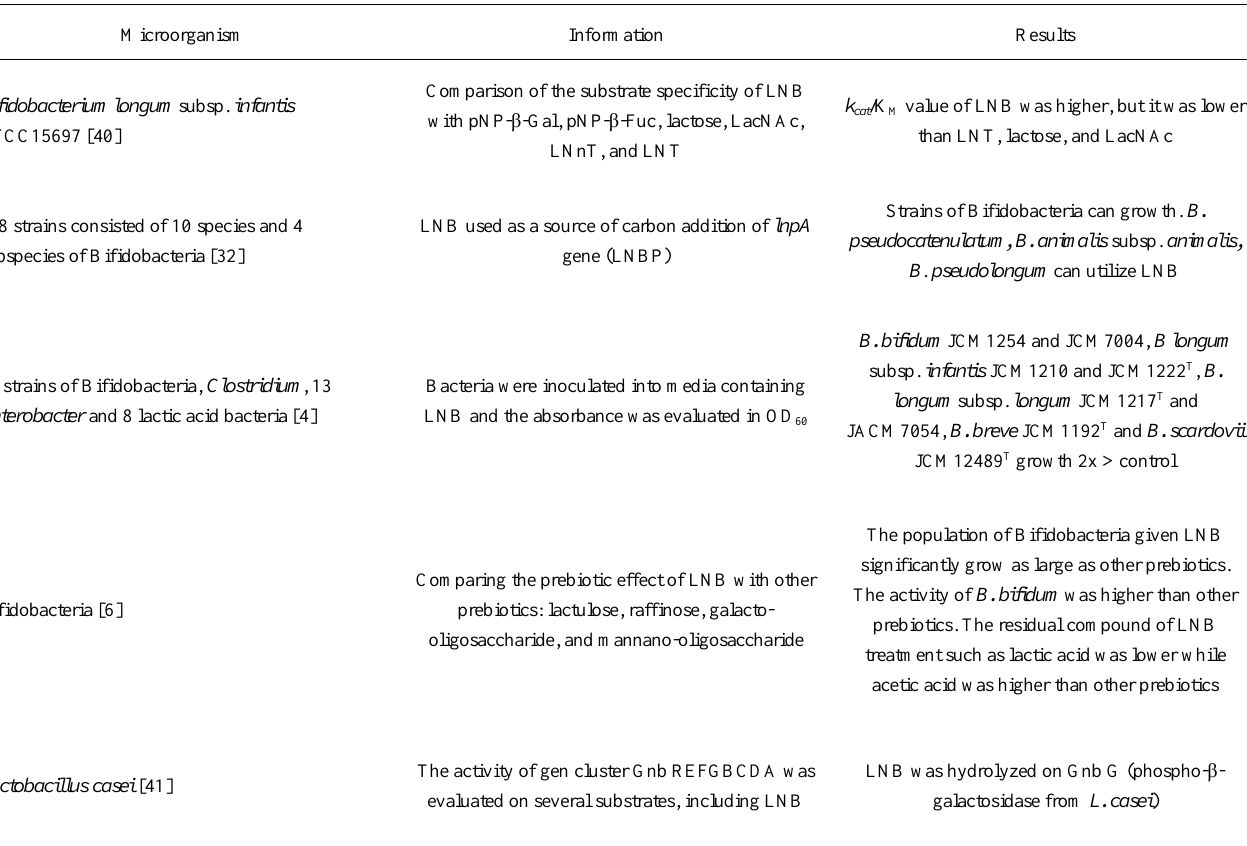
Table 1. The prebiotic effect of LNB in several